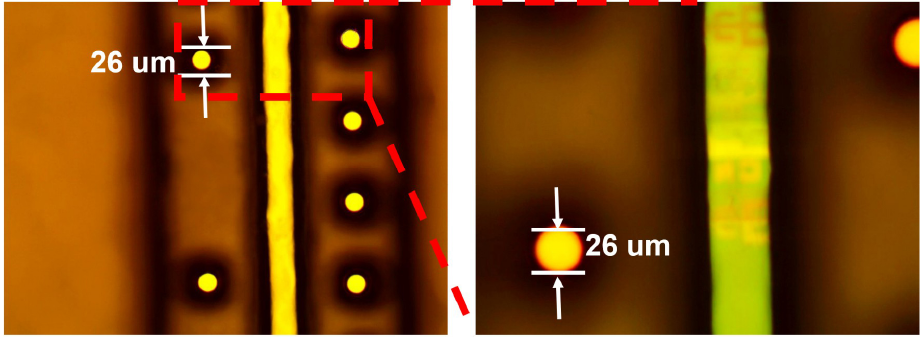
Figure 15. The outlook of the via after second passivation layer formation.